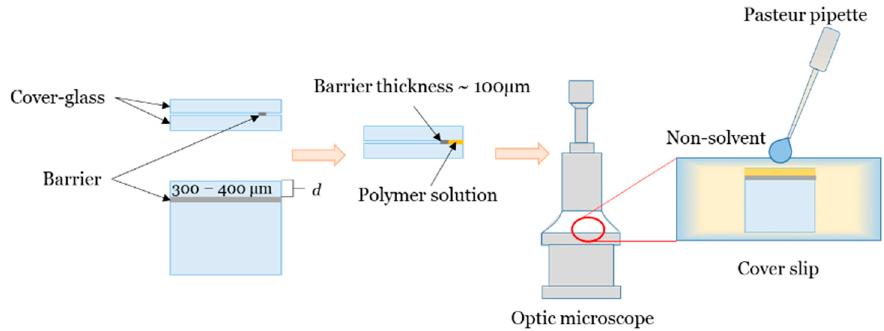
Figure 2. Scheme of a new technique for determination of the deposition rate in polymer solutions, which imitates the formation of a flat polymer membrane.